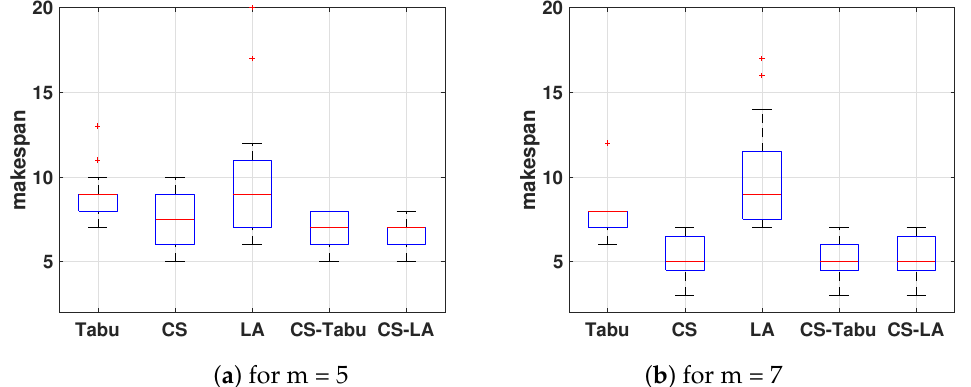
Figure 4. Performance of Tabu search algorithm, human players (crowdsourcing (CS)), LIST algorithm (LA), and the merged approaches (CS-Tabu and CS-LA) for solving the Identical Parallel Machines (IPM) scheduling problem for ( a ) m = 5, ( b ) m = 7